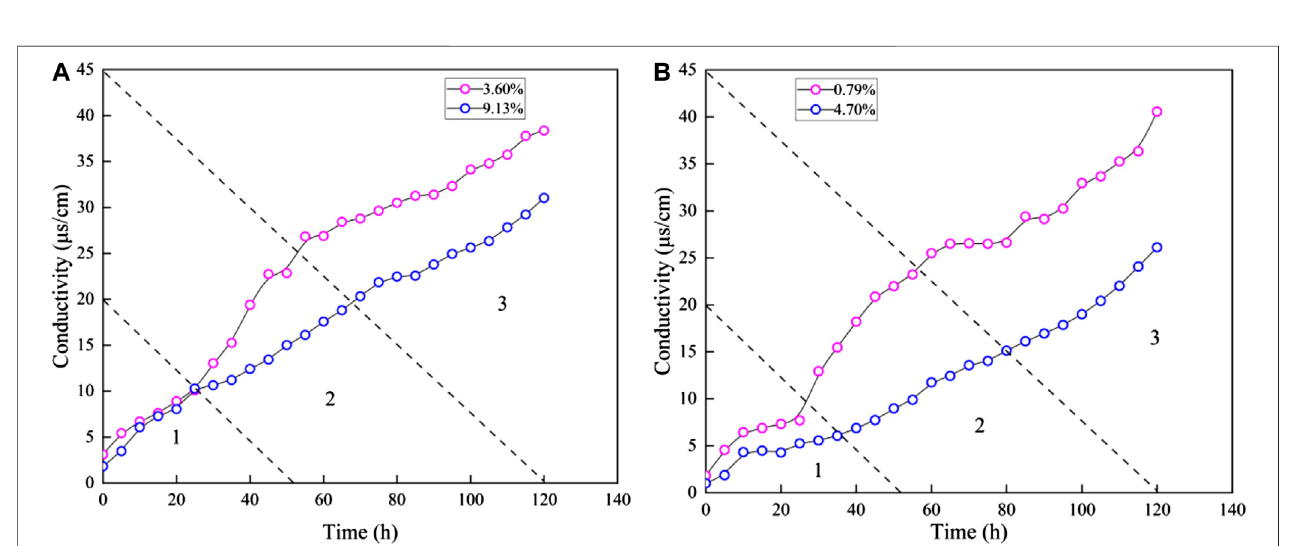
FIGURE 8 | Conductivity curves with different water content (A) ZN sediment and (B) LK sediment.